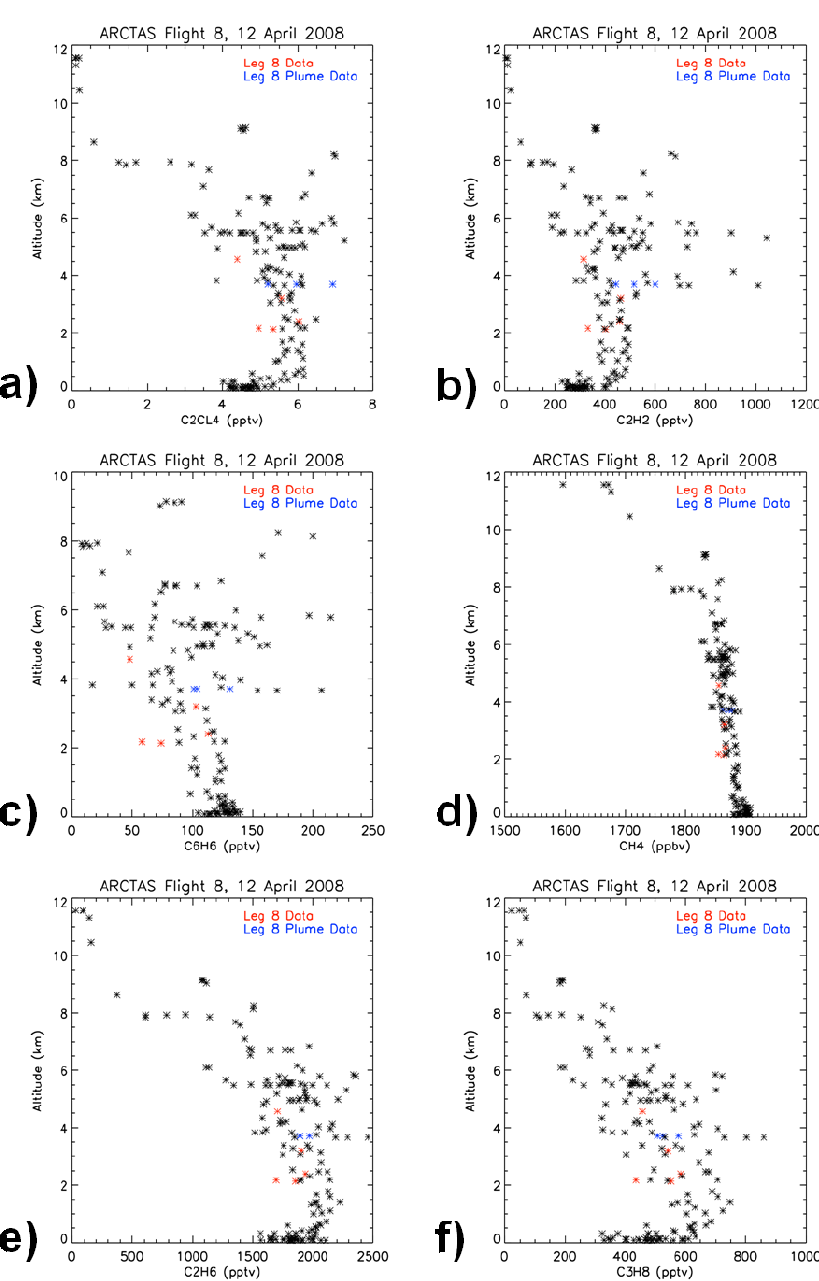
Fig. 14. Vertical distributions of data from flight 8 on 12 April 2008 for (a) C 2 Cl 4 , (b) C 2 H 2 , (c) C 6 H 6 , (d) CH 4 , (e) C 2 H 6 , and (f) C 3 H 8 . Red points are data from leg 8. Blue points also are from leg 8 but represent the sampled plume. Black points represent the remaining legs of flight 8.